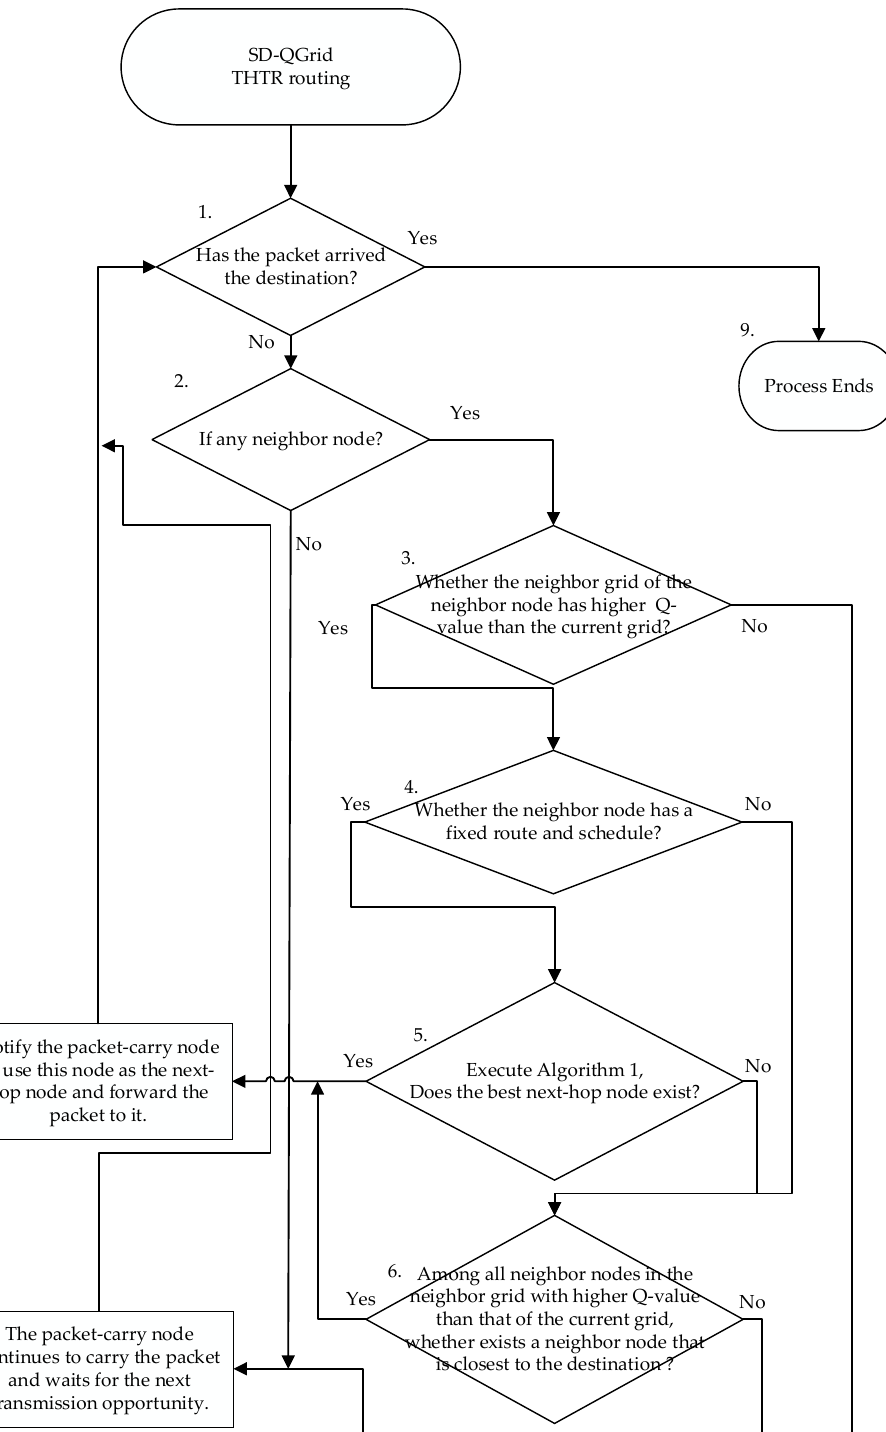
Figure 10. Flow of the SD-QGrid online routing decision process. Algorithm 1 uses the Q-value to calculate up to nine (next-hop grid, two-hop next grid) combinations based on the grid 𝐺𝑟𝑖𝑑 (cid:3002) where the current packet is located. It then selects the two-hop next grid combination, depending on the next-hop grids with the top three Q-values in line 5. For all neighbor nodes B of A , Algorithm 1 uses the link expiration time of adjacent vehicles to filter the candidate relay nodes in line 8. It calls Algorithm 2, i.e., the One-Two-Hop Value (A, B ) , in line 9 to obtain 𝑇𝑤𝑜𝐻𝑜𝑝𝑉𝑎𝑙 (cid:3003) and 𝑂𝑛𝑒𝐻𝑜𝑝𝑉𝑎𝑙 (cid:3003) .